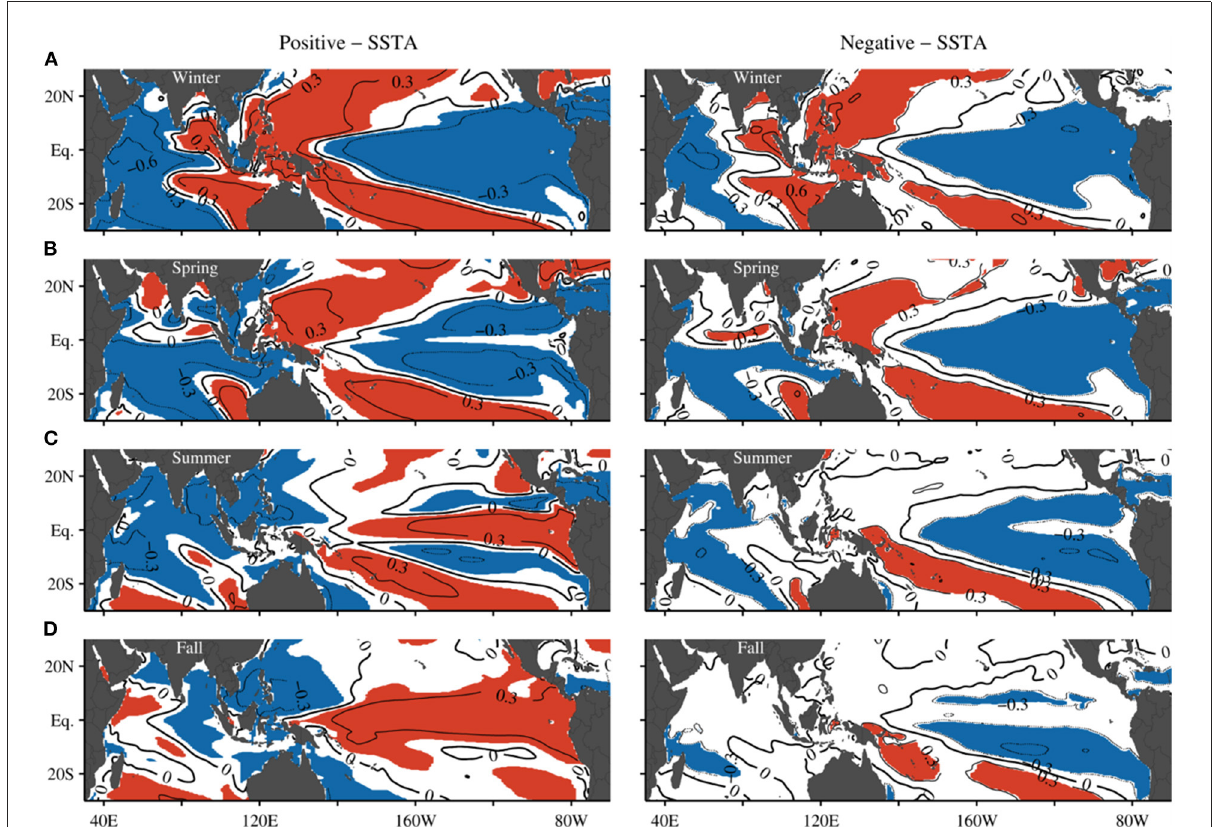
FIGURE11 Comparison of lag correlations between the SSTA in STIO in fall and the tropical Indo-Pacific SSTA in the following four seasons for the positive (left column) and negative (right column) phases of the decadal variability in the CCSM4 historical simulations. (A) Winter (December to February). (B) Spring (March to May). (C) Summer (June to August). (D) Autumn (September to November). The contour interval is 0.3. Red and blue shades indicate 99% confidence level of positive and negative correlation,